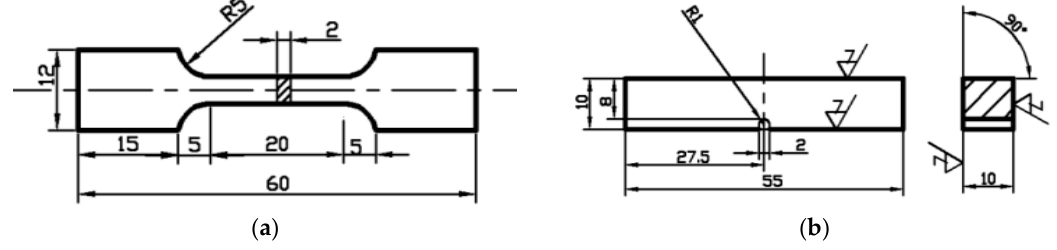
Figure 2. Configurations of specimens for ( a ) tensile and ( b ) impact toughness